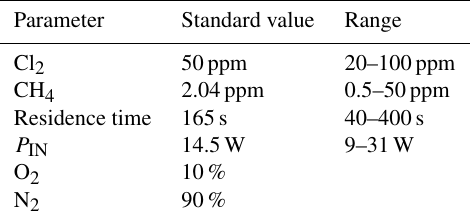
Figure 6. RE% for the steps of exp. D, F and H as found experi- mentally (white stripes) and by the model (grey). (a) Steps D2 and D6–D9 were utilized to generate J Cl (b) Exp. E and (c) exp. H. Table 5. Parameter